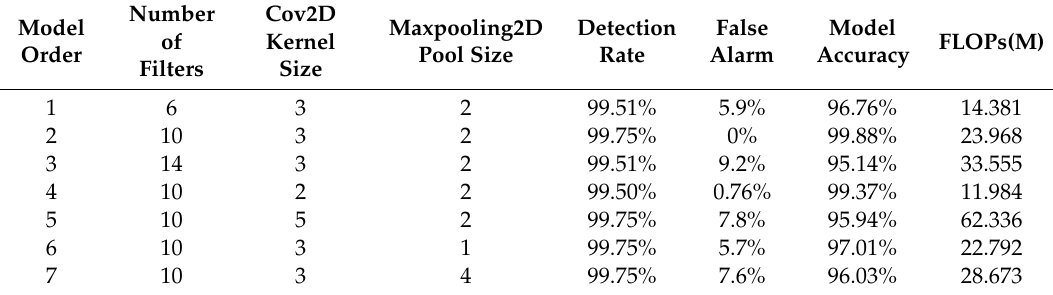
Table 4. Comparison results for different glance network structures.